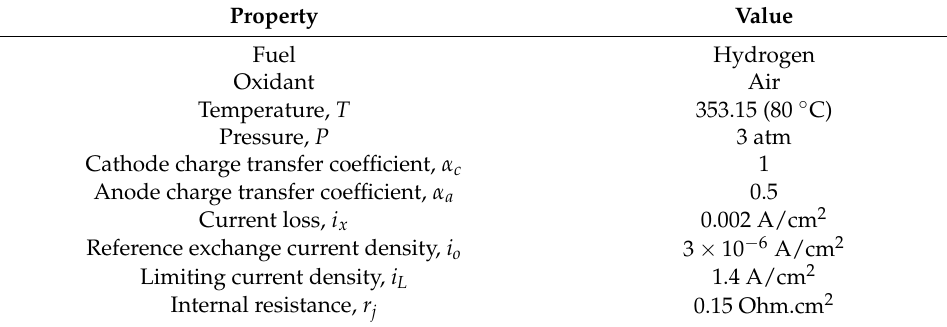
Table 3. Operating and electrode parameters for the base